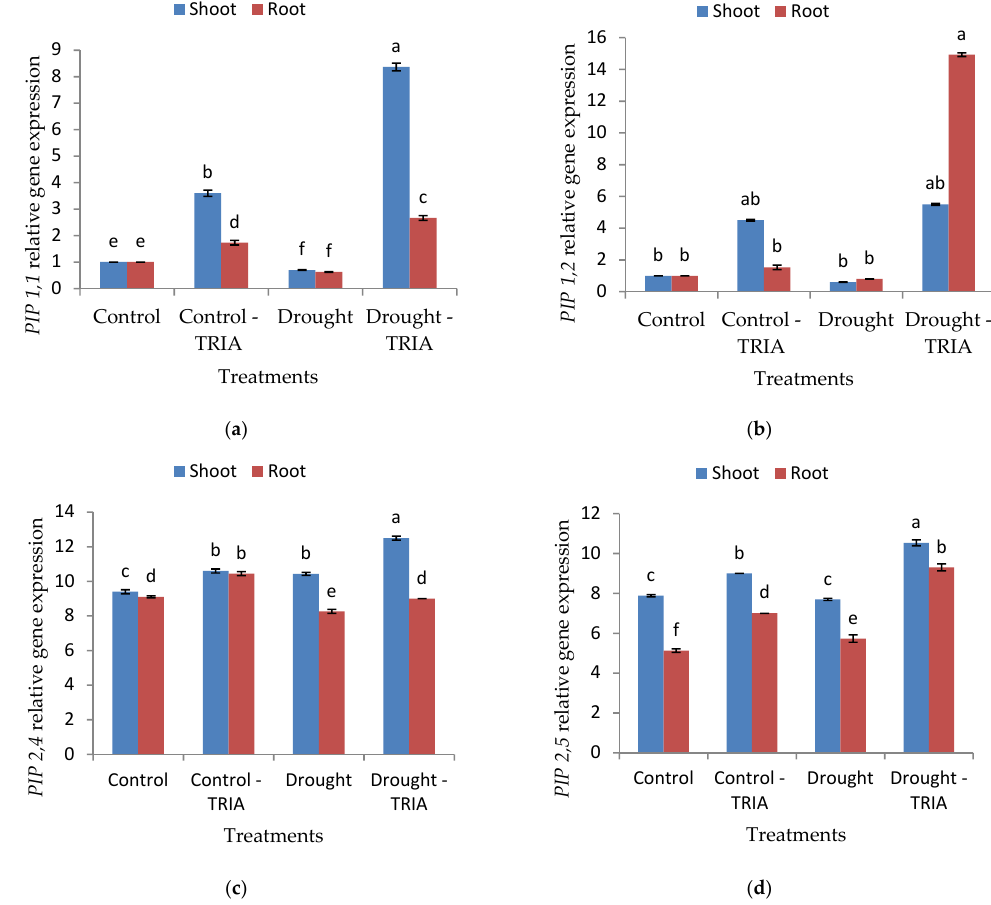
Figure 5. Effects of TRIA (35 ppm) treatment on mRNA expression of plasma membrane intrinsic protein ( a ) PIP1,1 , ( b ) PIP1,2 , ( c ) PIP2,4 , and ( d ) PIP2,5 of drought-stressed rice seedlings. Each value is the mean of three replicates ± SE. Columns with different letters are significantly different at p ≤ 0.05.